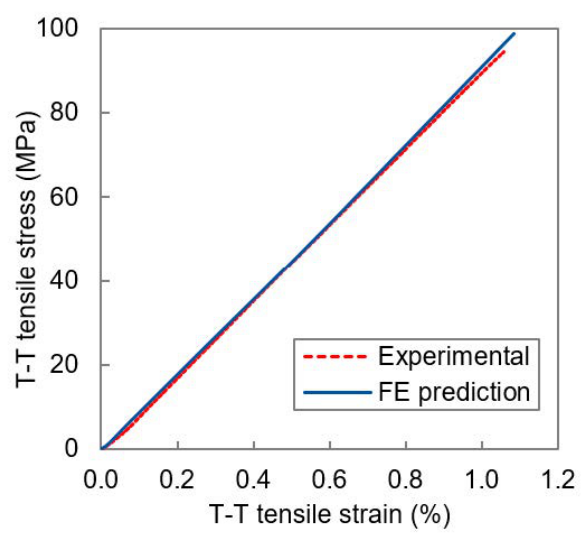
Figure 12. Experimental and finite element analysis (FEA) predicted stress–strain curves for the three-point bend geometry.